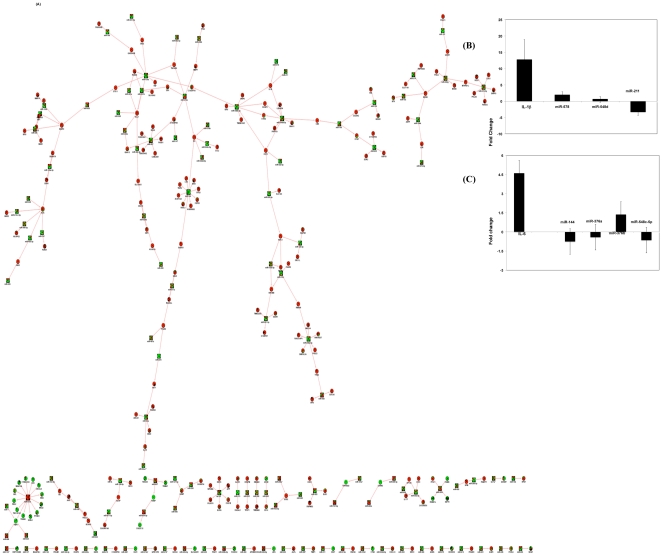
Network of predicted miRNA-mRNA interactions.
(A) Regression-based method was used to predict the miRNAs (green circles) that are actively regulating mRNAs (red diamonds) in our dataset. (B&C) Validation of miRNA-mRNA interaction partners by RT-PCR using independent samples (n = 6) for IL-1ß(B) and IL-6 (C).